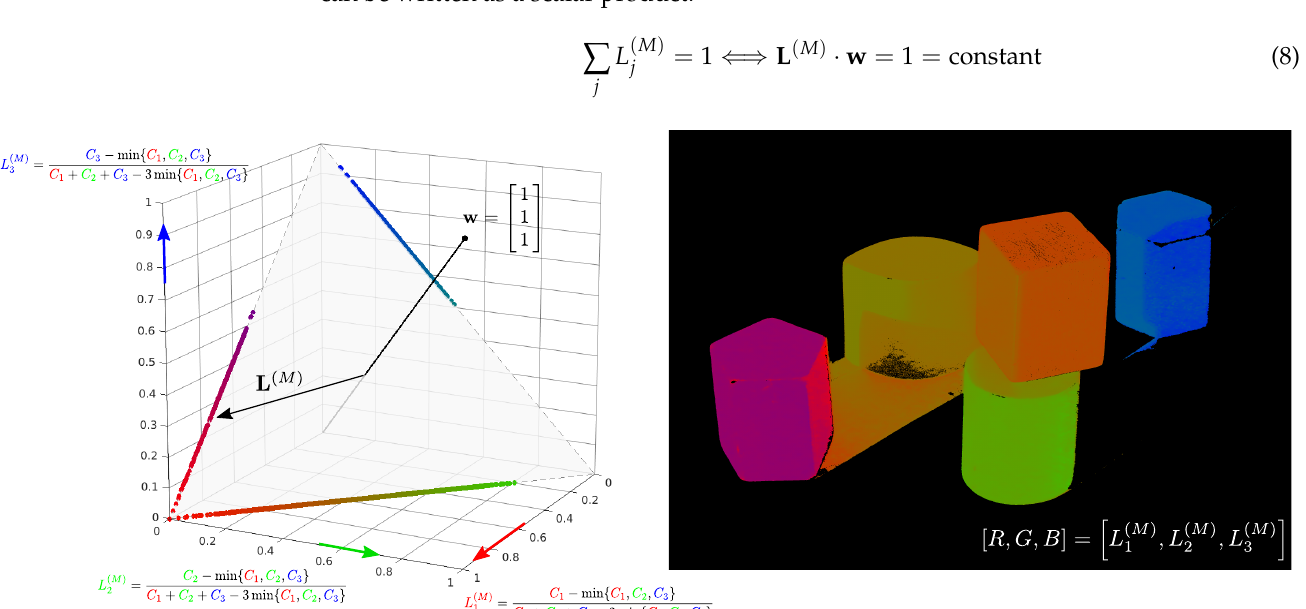
Figure 4. Spectral invariant proposed by Montoliu et al., computed on the image of Figure 3. ( Left panel ): location of transformed pixel values in the RGB unit cube, invariant L ( M ) is constrained in a plane orthogonal to the white vector w = [ 1,1,1 ] T . ( Right panel ): transformed RGB image. Note how light reflected from the yellow oval toy produces a yellow hue on the white floor and also alters the hue on the rightmost side of the purple pentagon